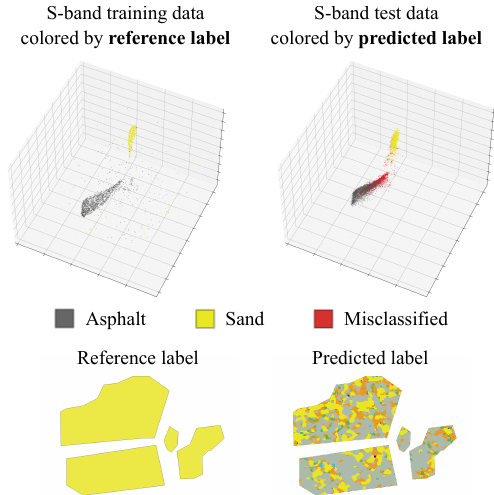
Figure 7. S-band data: Confusion of data points with reference label meadow or farmland .